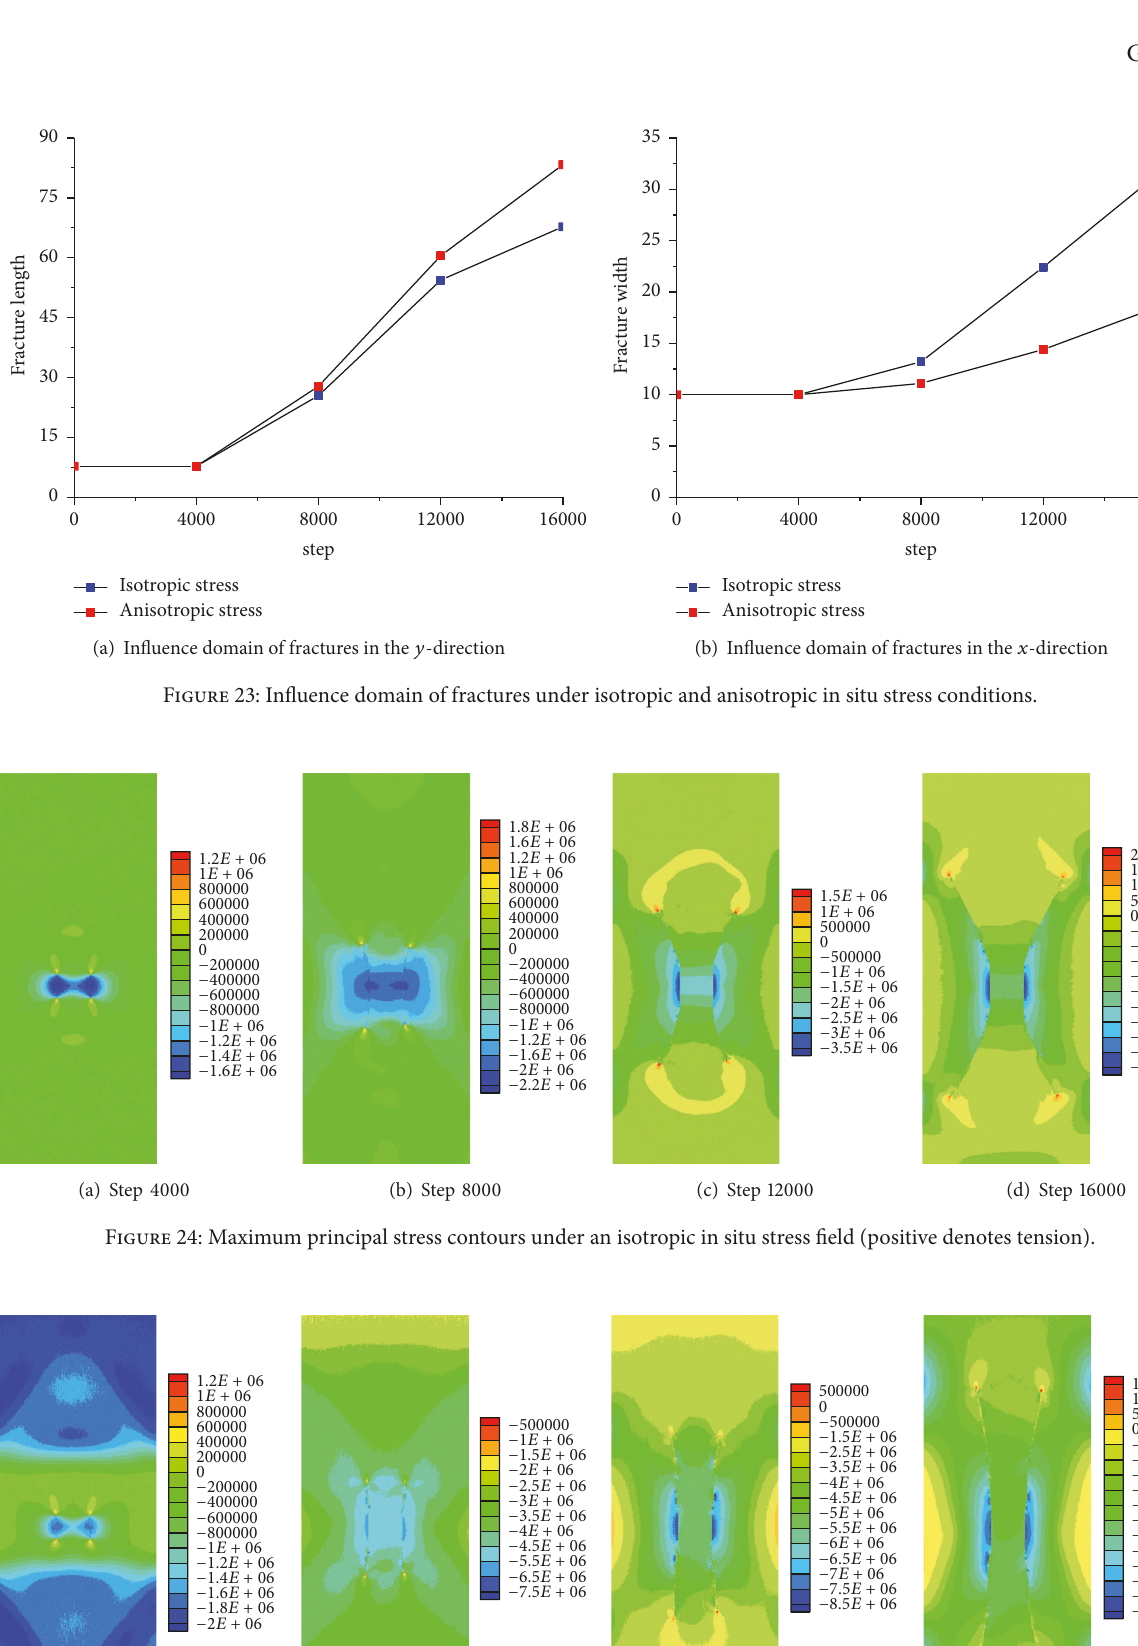
06−1.6E + 06−1.8E + −2E +